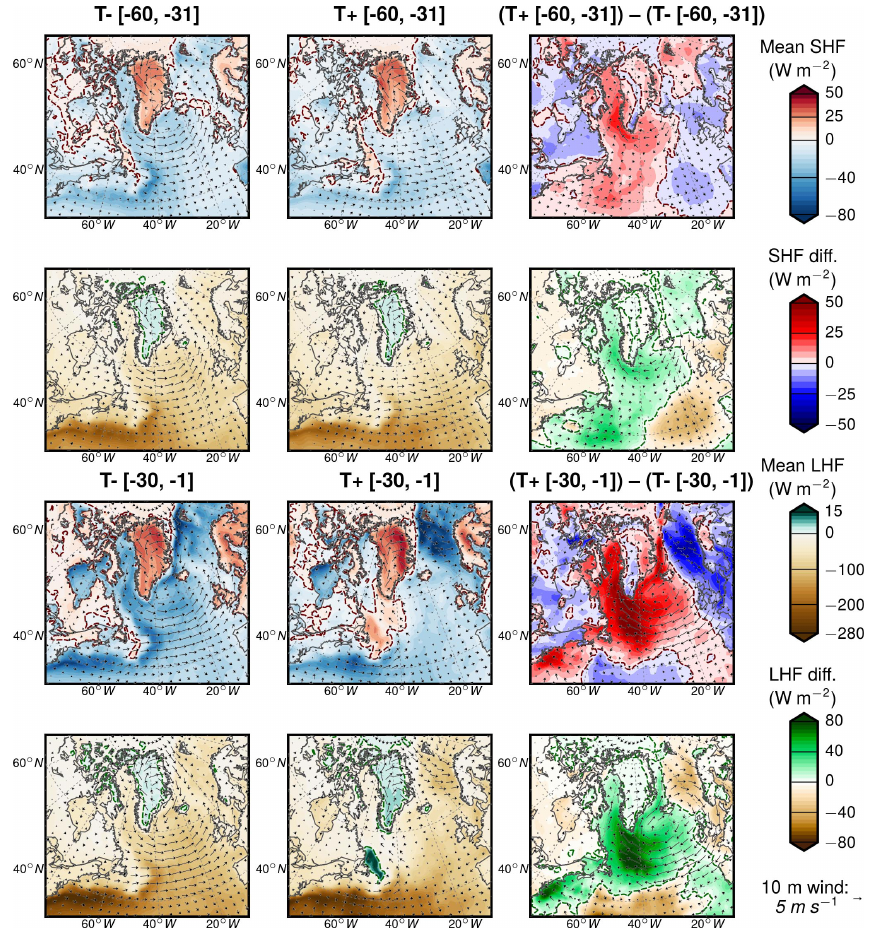
Figure 6. North Atlantic sensible heat flux (SHF), latent heat flux (LHF), and 10m wind composites from ERA-Interim for T + and T − events at KAN_B and their differences for the two periods preceding the Baffin Bay date of sea ice advance